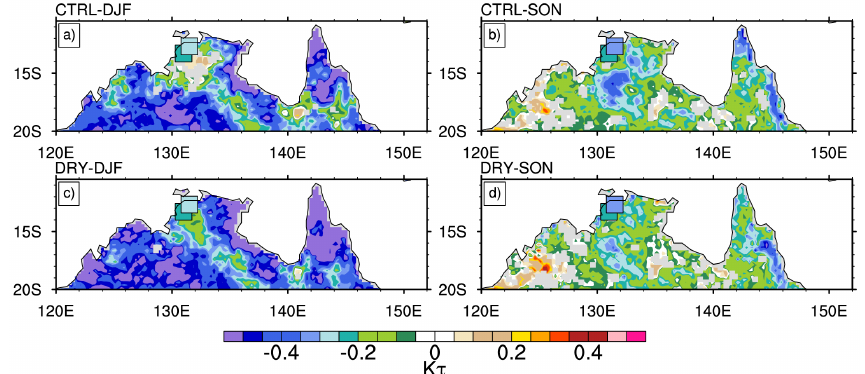
Figure 7. The ensemble median Kτ correlation metric between the afternoon time (local) EF and the afternoon computed LCL from (a) CTRL over DJF, (b) CTRL over SON, (c) DRY over DJF, and (d) DRY over SON. The black outlined squares in (a–d) denote the values from the flux tower sites. Only statistically significant (95% confidence level) results are shown in (a–d)